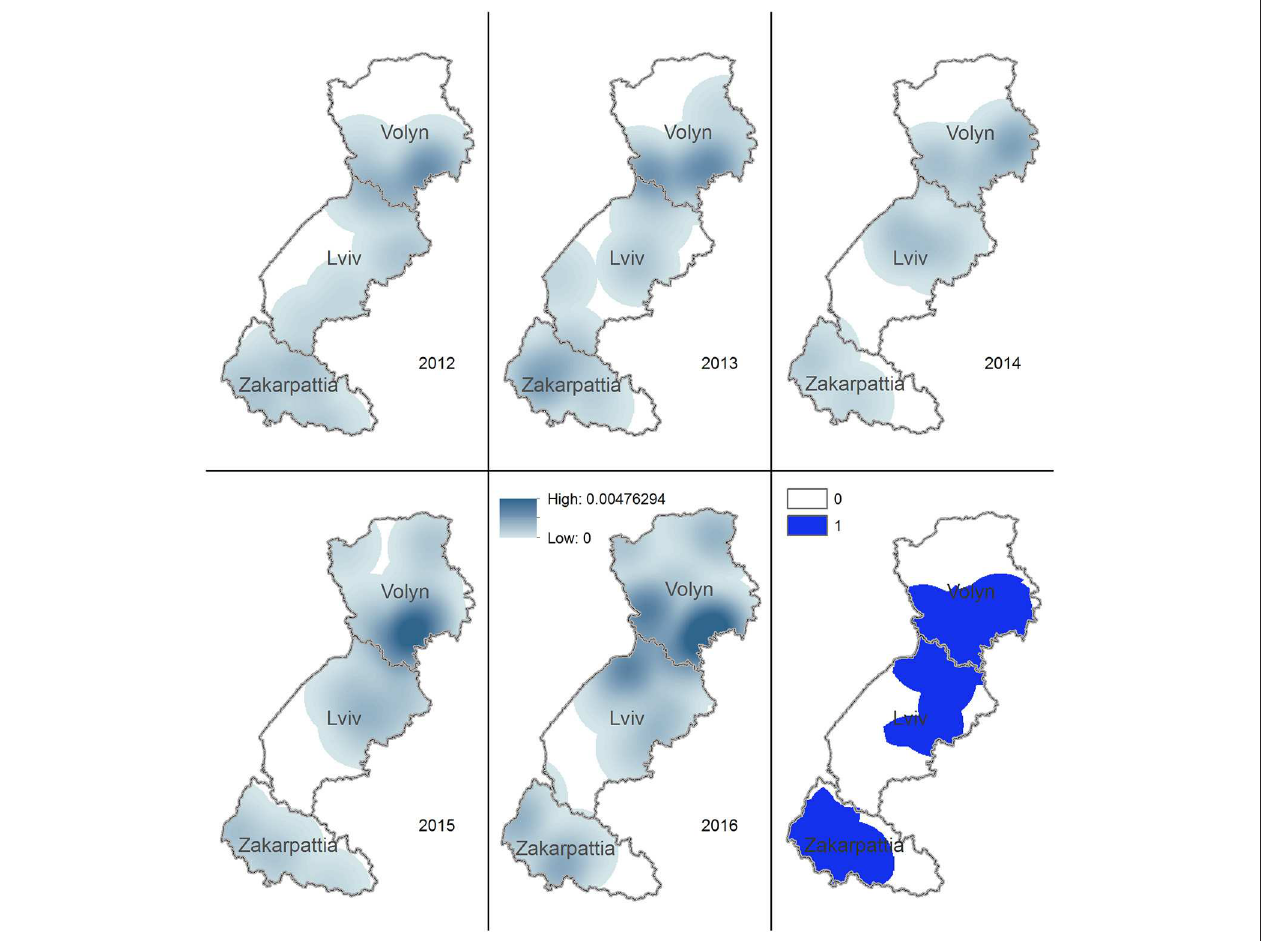
FIGURE 5 | Kernel density estimation of rabies cases in domestic carnivores in Volyn, Lviv, and Zakarpattia oblasts. Yearly maps representing the areas with higher density of rabies cases in domestic dogs and cats for years 2012–2016 are shown. Solid blue color on the bottom right figure marks the territory, where the density of cases is consistently > 0 across all